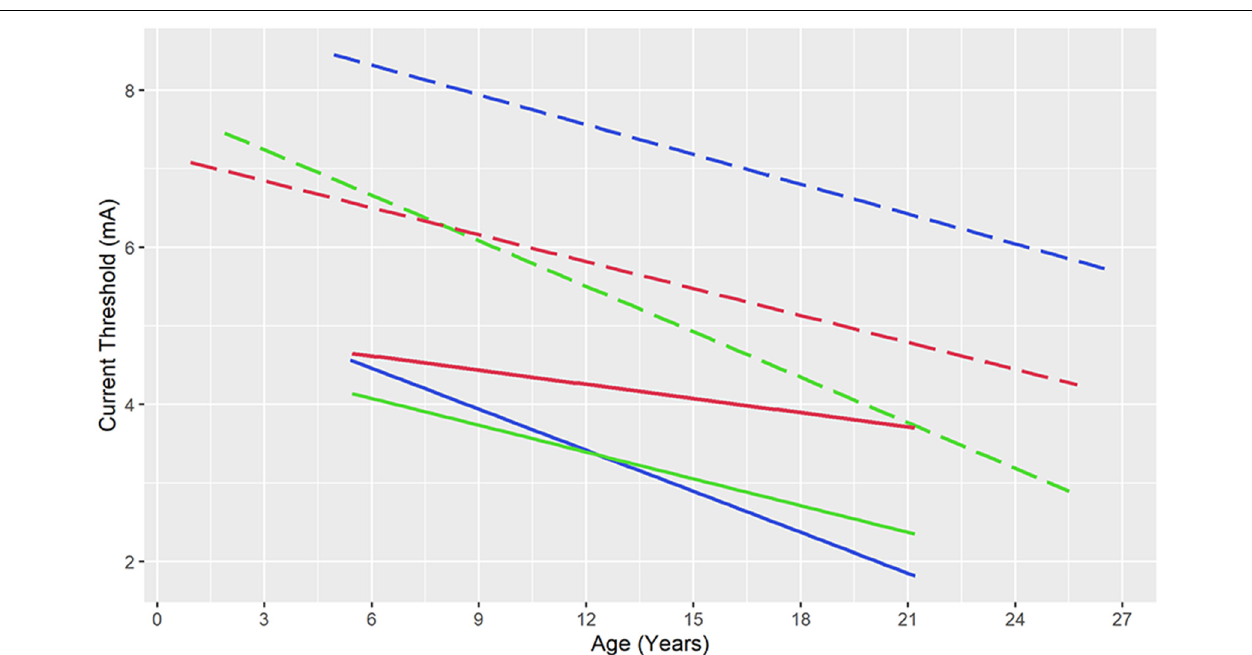
FIGURE 3 | Current thresholds for speech and language responses (blue), motor responses (green), and after-discharges (red) during electrical stimulation mapping with stereotactic electroencephalography (solid lines) and subdural electrodes (dashed lines). Note that after-discharge thresholds are lower than language thresholds (throughout the included age range) and motor thresholds (up to 8-years of age) raising concerns for the safety of subdural electrical stimulation, while functional thresholds remain below after-discharge thresholds for stereotactic electrodes. Ordinary least squares regression lines based on data from Zea Vera et al. (2017) and Arya et al. (2019,